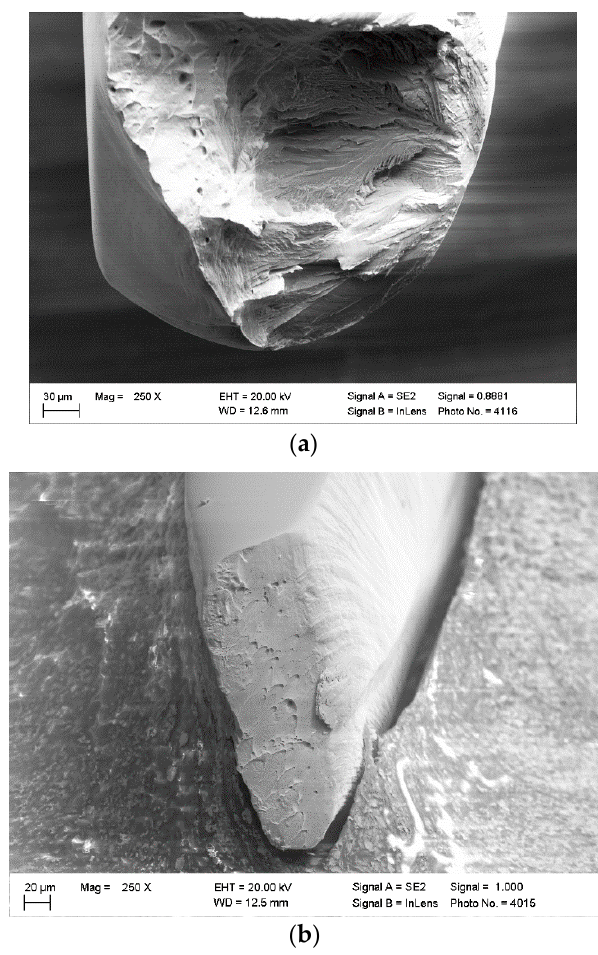
Figure 7. SEM images of representative fracture surfaces of an oligo-crystalline 10% cold drawn wire after ( a ) 530,000 cycles and ( b ) 500 cycles.